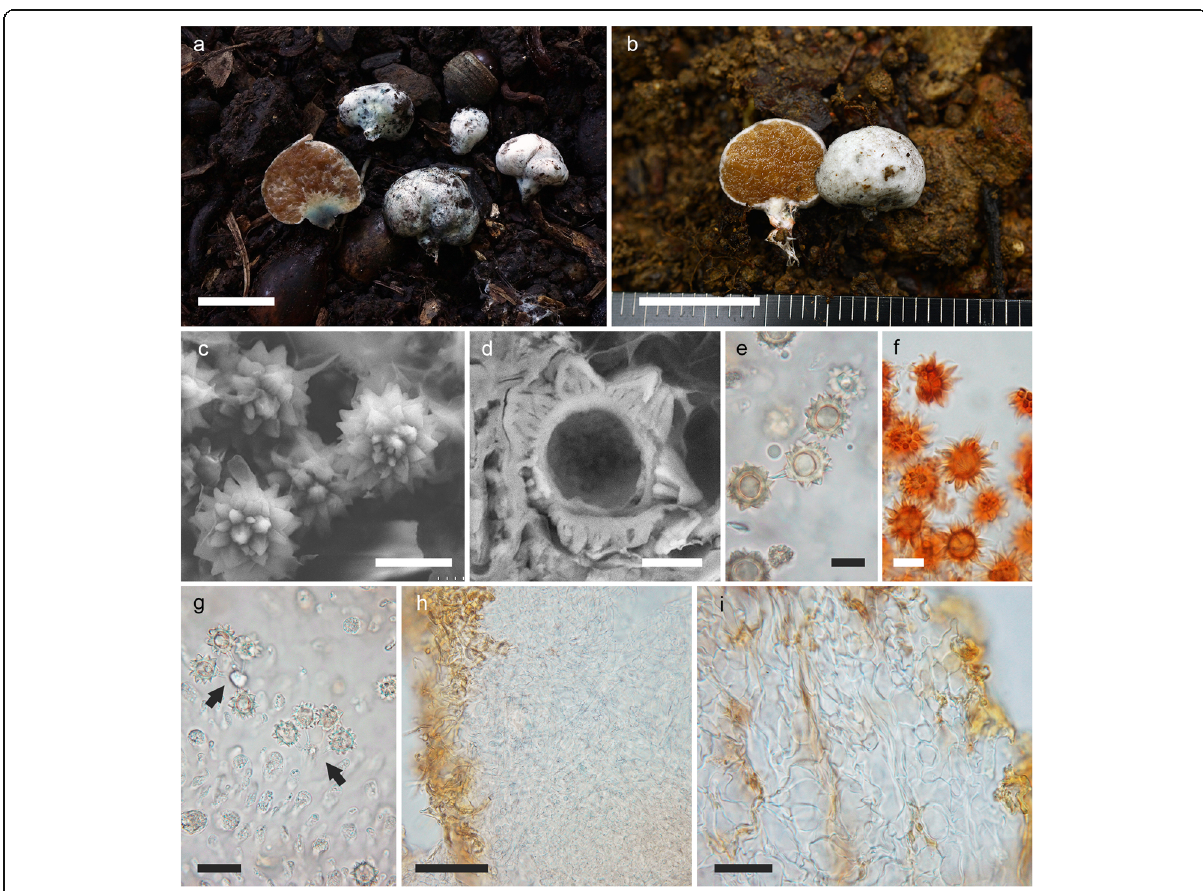
Fig. 5 Octaviania tomentosa . a – b Basidiomata ( a holotype from central Honshu, Japan [KPM-NC 27954]; b specimen from Amami-oshima Island, Japan [KPM-NC 23934]). c Basidiospores under SEM (holotype). d section of a basidiospore showing multiple slit-like cavities inside the spiny ornaments. e Basidiospores mounted in water (KPM-NC 27945). f Dextrinoid basidiospores with elongated ornamentation mounted in lactic acid after pre-soaking in Melzer ’ s reagent (KPM-NC 23934). g Basidiospores connected to 4-spored basidia (arrows; KPM-NC 27955). h Peridium of an immature basidiome (KPM-NC 27955). i Peridium of a mature basidiome (KPM-NC 27953). Scale bars: a – b = 1 cm, c , e – f = 10 μ m, d = 5 μ m, g , i = 20 μ m, h = 50 μ